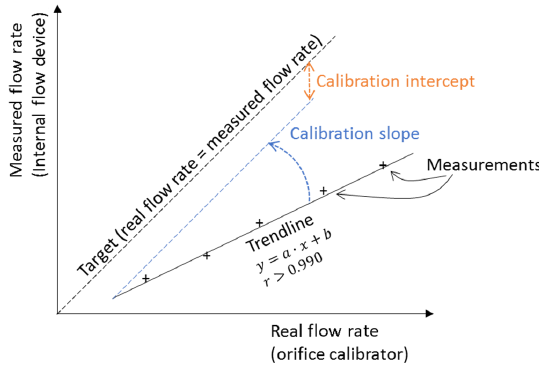
Figure 4. Calibration using a linear correlation with intercept and